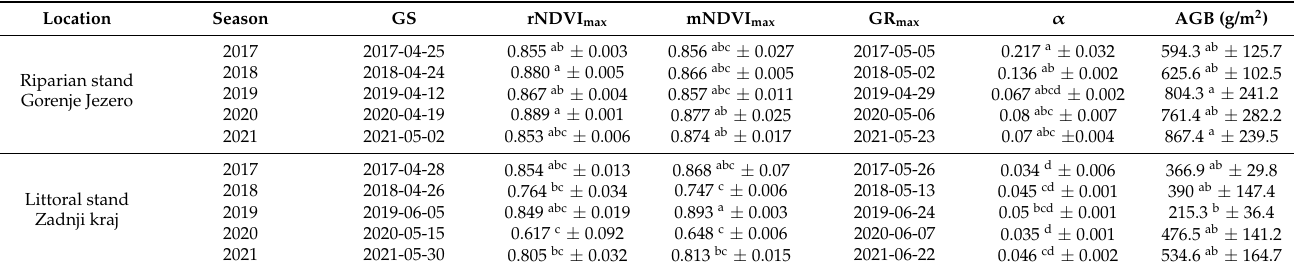
Table 3. Model results and above-ground biomass at the end of each growing season from 2017 to 2021 for the riparian reed stand at Gorenje Jezero and the littoral reed stand at Zadnji kraj. (GS—the date of growth-start; rNDVI max —maximal NDVI value of our NDVI dataset; mNDVI max —maximal NDVI value predicted by model; GR max —date of maximal growth rate; α —initial rate of NDVI increase; AGB—above-ground biomass at the end of the growing season expressed in grams per square meter). Compact letter displays show differences between values based on the Dunn post hoc